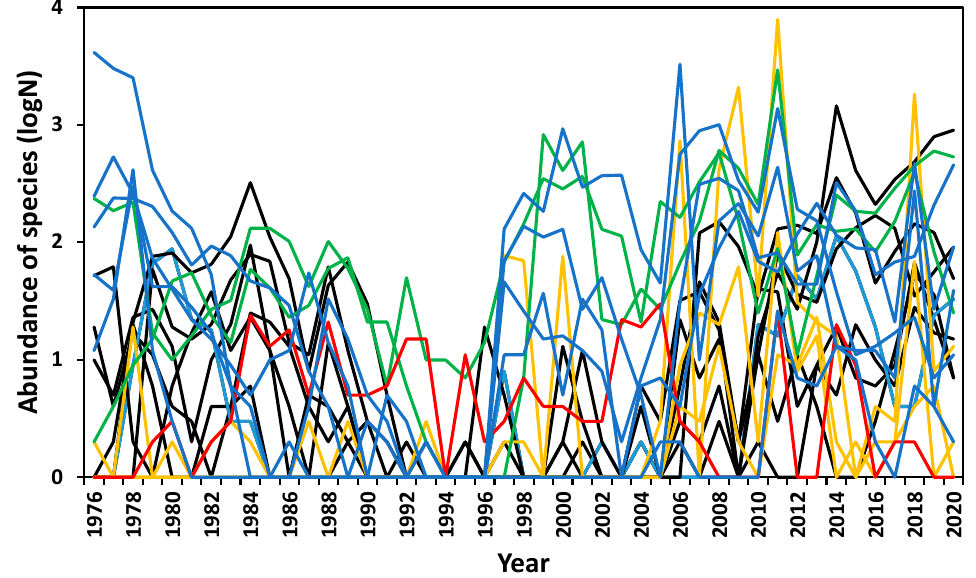
Figure 8. Annual changes in community composition at the gravel plain study site showing members of group A (blue), B (yellow), C (black), D (green), and E (red). Group F members, which appeared mainly after 2006, are not shown.